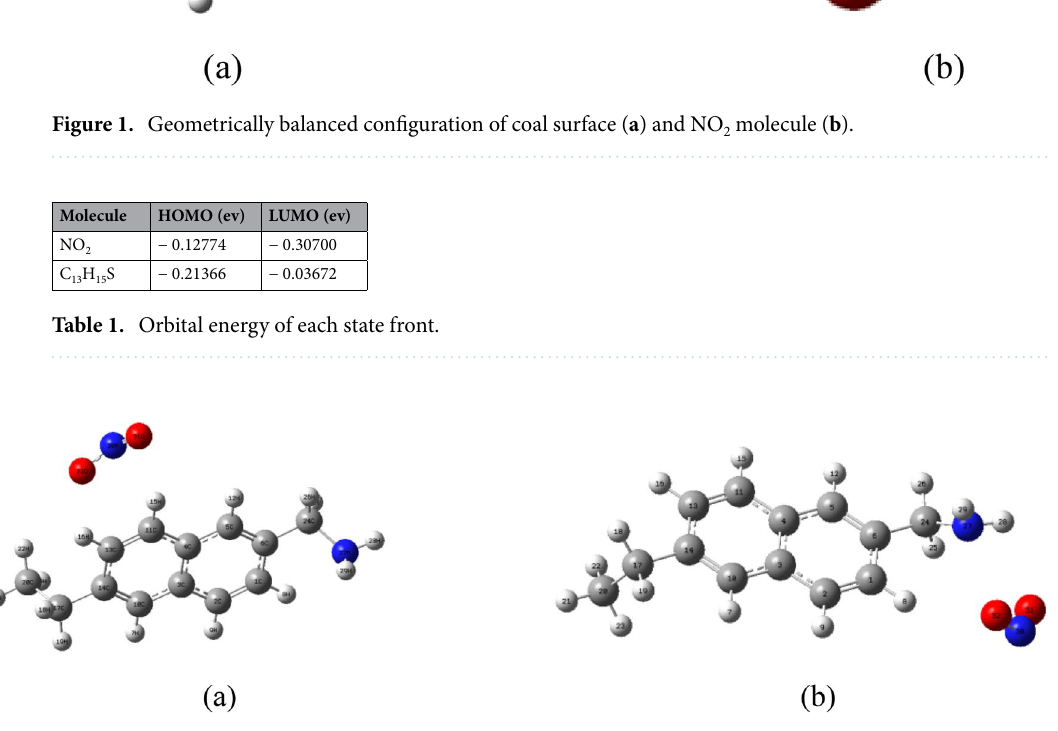
Figure 2. Equilibrium configuration diagram of single NO 2 molecule adsorption on benzene ring ( a ) and side chain ( b ) on coal surface.